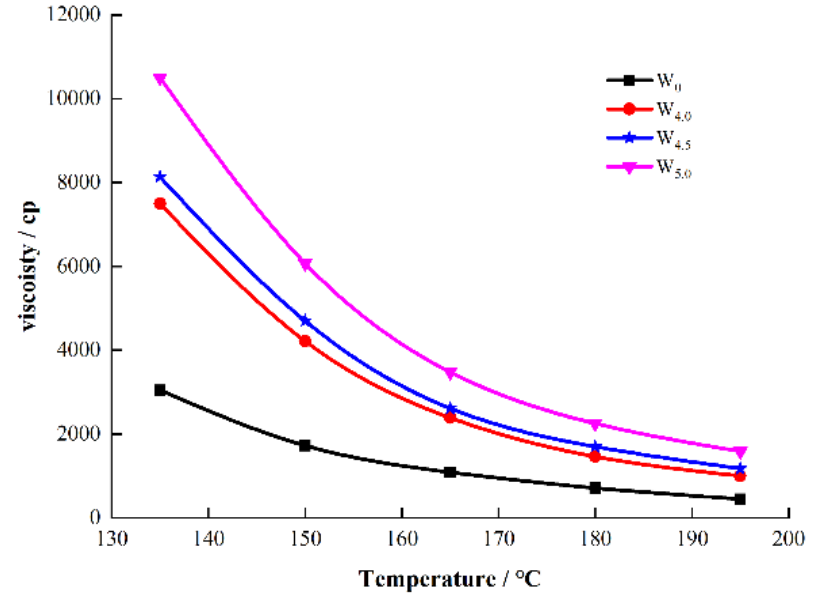
Figure 13. Viscosity of crumb rubber modified asphalt with different TOR content.